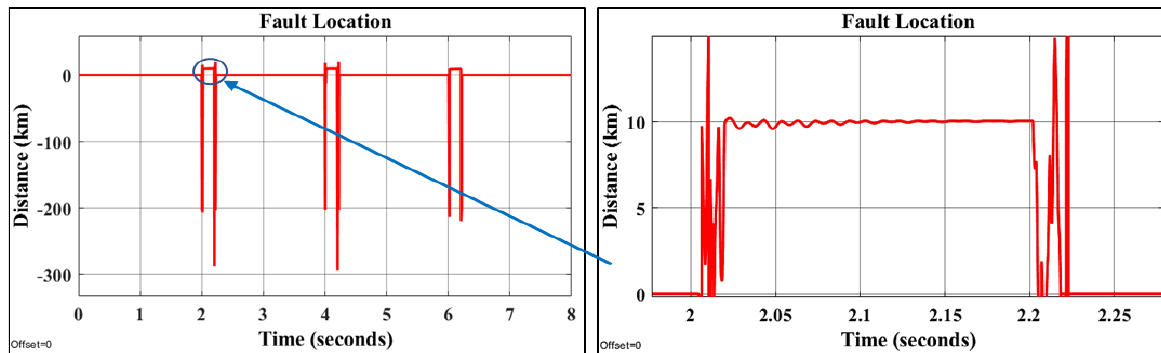
Figure 18. Fault location (Scenario 3, Case 1) .